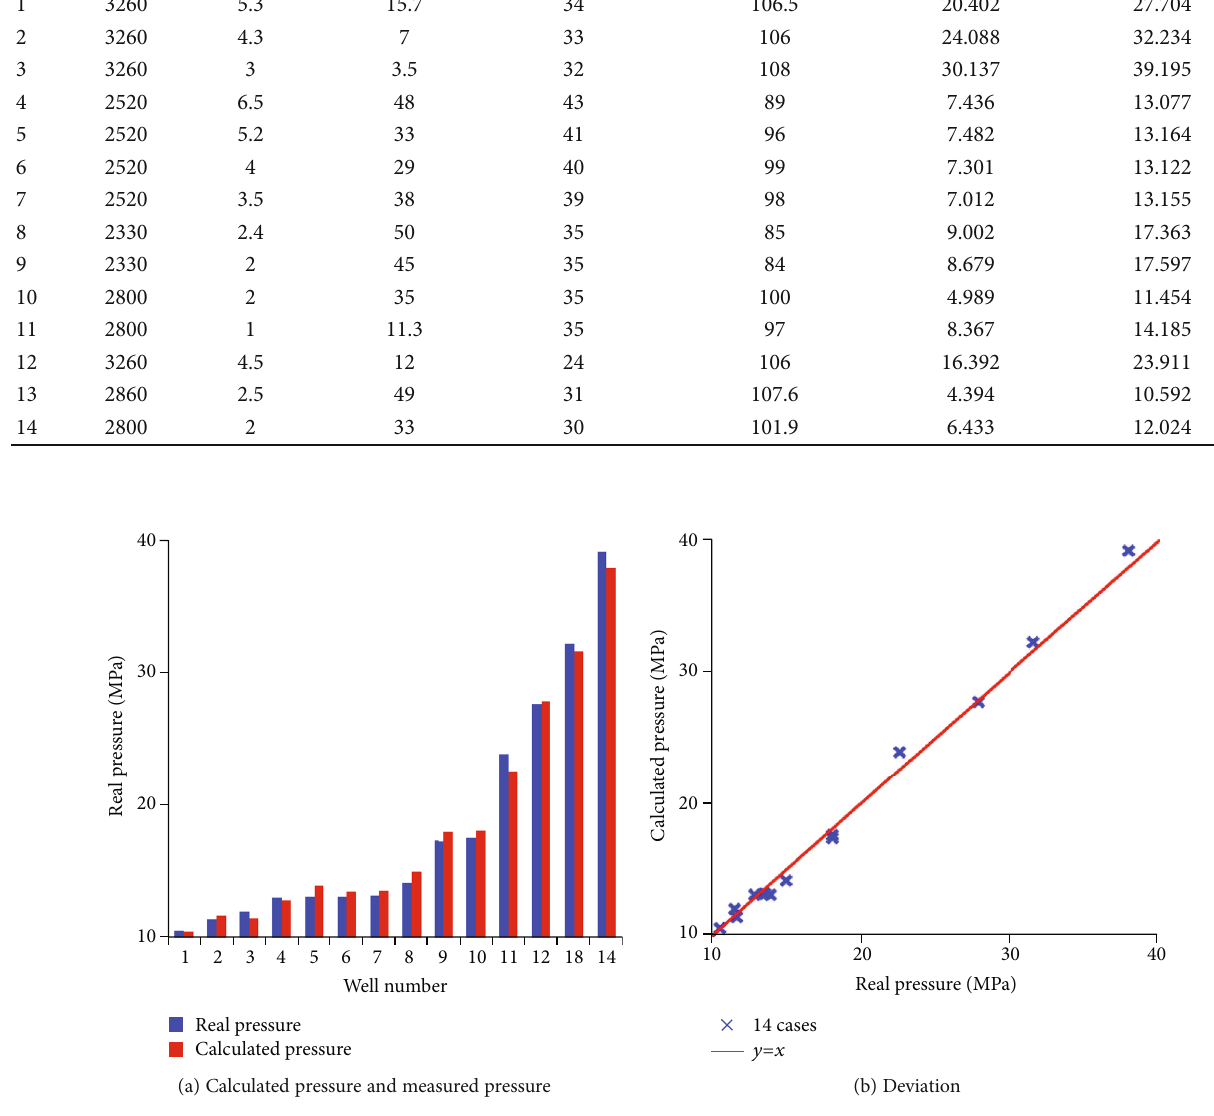
Figure 3: Comparison between calculated results and measured data of fl owing bottom-hole